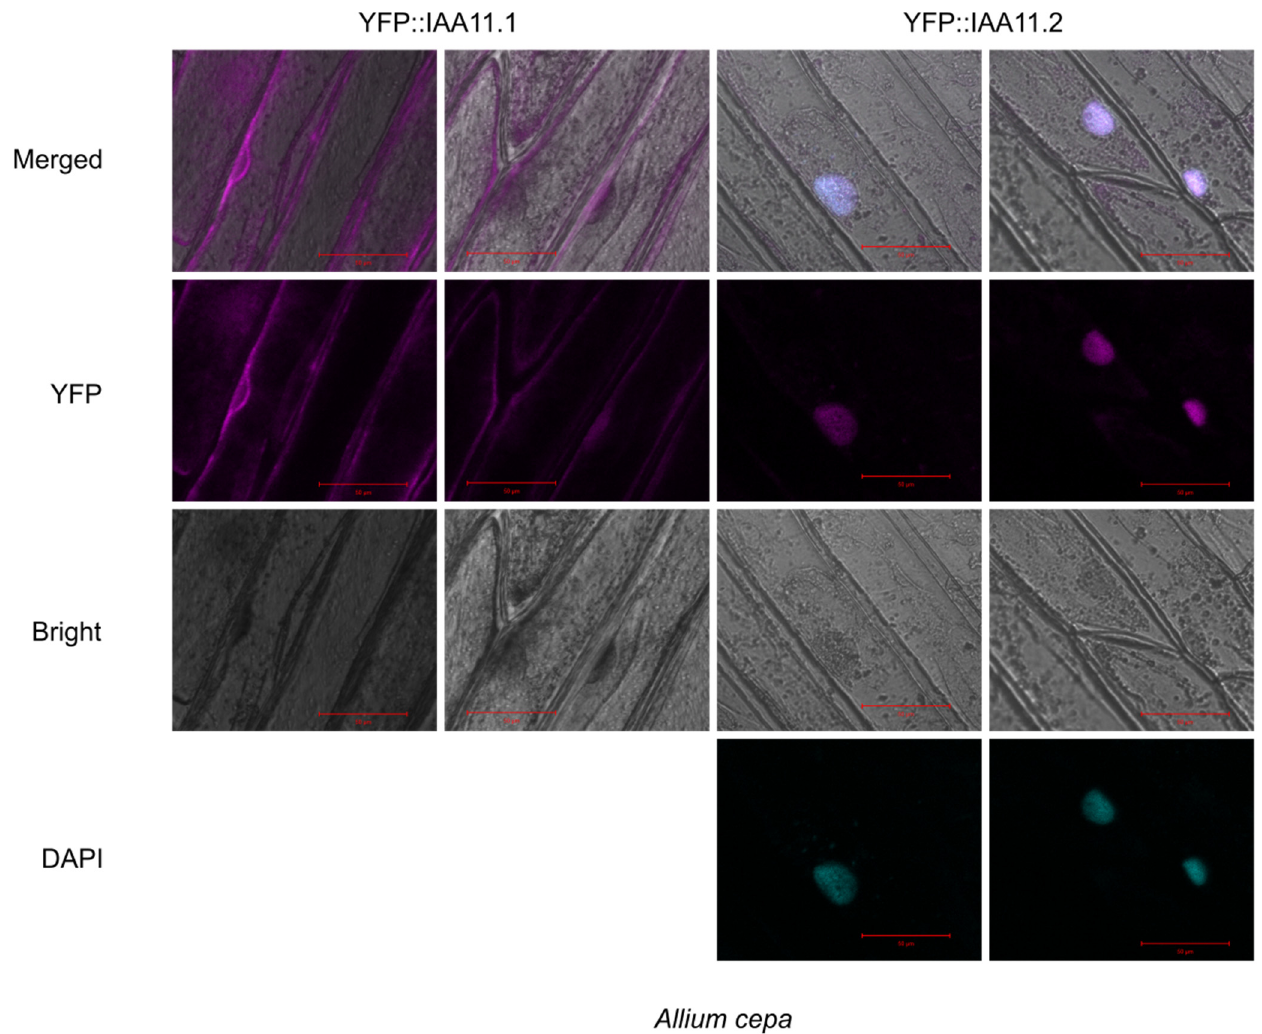
Figure 7. Subcellular localization of IAA11 protein variants in Allium cepa . Transient expression of fusion proteins: YFP::IAA11.1 and YFP:IAA11.2 in Allium cepa adaxial epidermis under 35S constitutive promoter. Pictures were taken 72 h post agrobacterium infiltration using confocal microscopy. Magenta and cyan colors represent Yellow fluorescent protein (YFP) and 4’,6-Diamidino-2-Phenylindole, Dihydrochloride (DAPI) fluorescence, respectively. Red scale bars represent 50 µm.